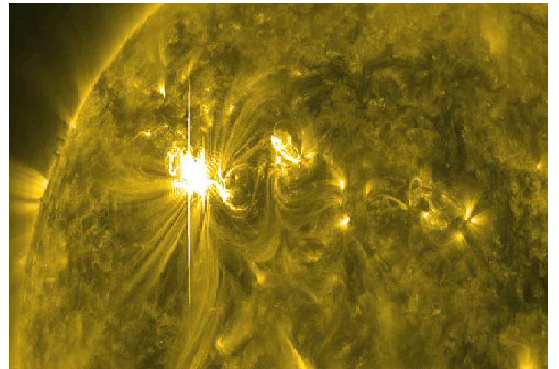
Figure 2. Image of solar flare X5.4 occurred at active region AR1429 on 7 th March 2012 at 00:24 UT. © Solar flare Image Copyright 2011, NASA.